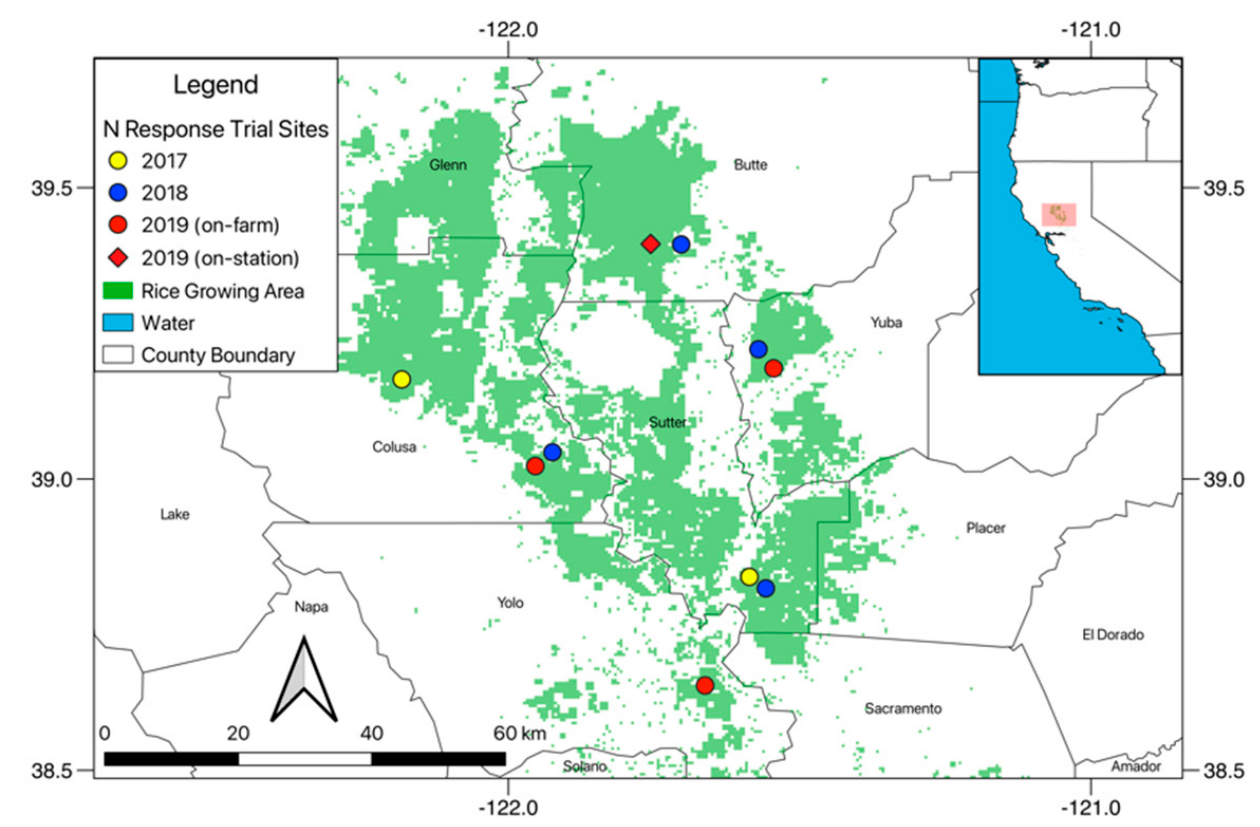
Figure 1. A map of N response trial sites established during the 2017 to 2019 growing seasons throughout the Sacramento Valley rice growing area of California, USA.